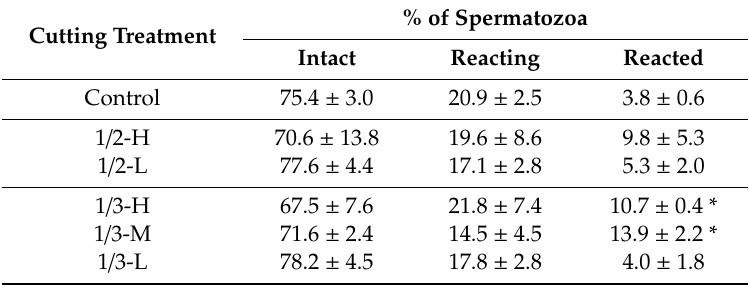
Table 2. The e ff ects of ultrasonic cuttings on the acrosome integrity of KPN spermatozoa. % of Cutting Treatment